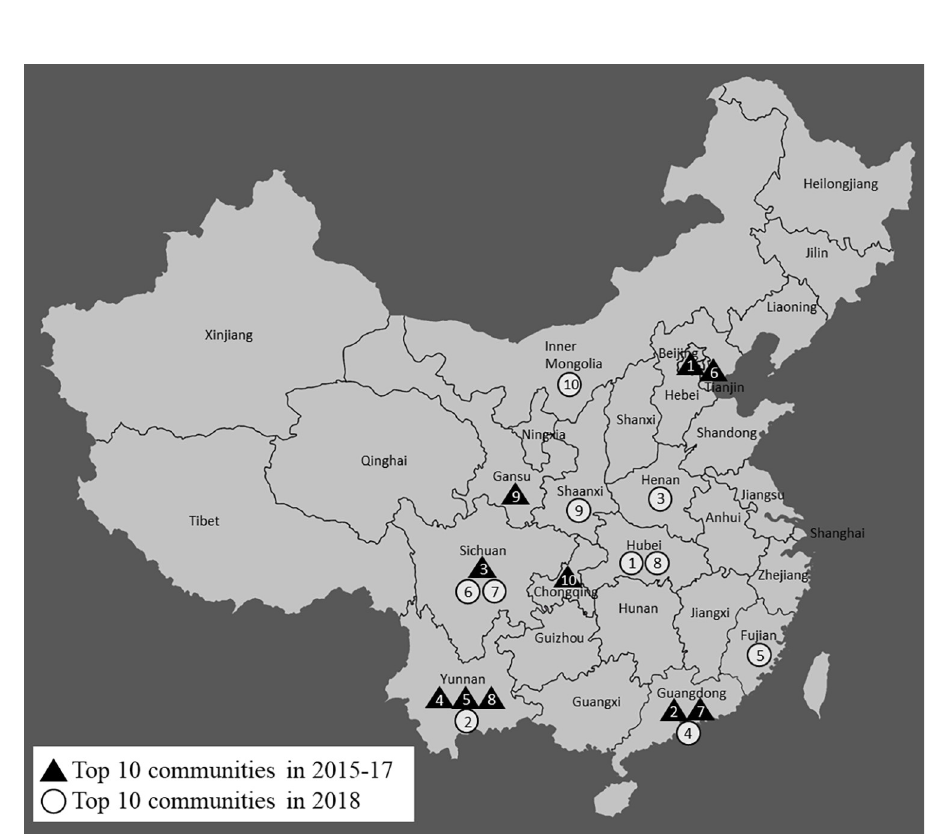
Fig 2. Places with the highest incidence of lung disease